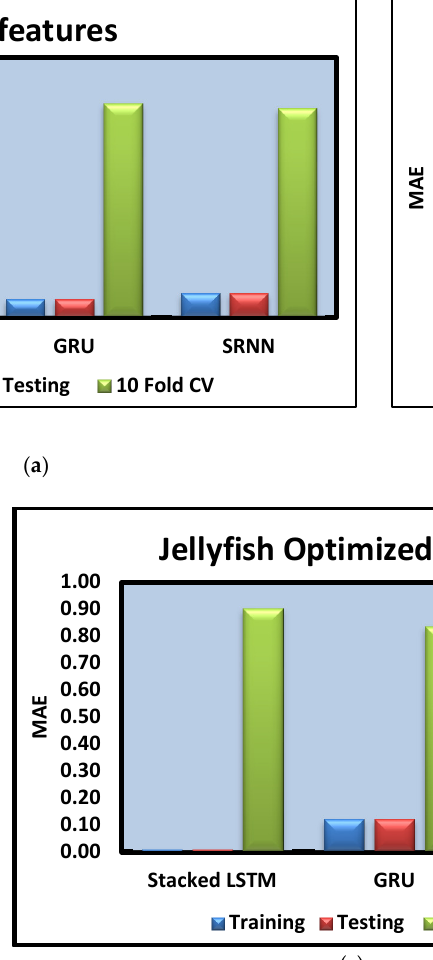
Figure 12. MAE values from three models. ( a ) All features. ( b ) Ex-AI features. ( c ) Jellyfish-optimized Ex-AI features.